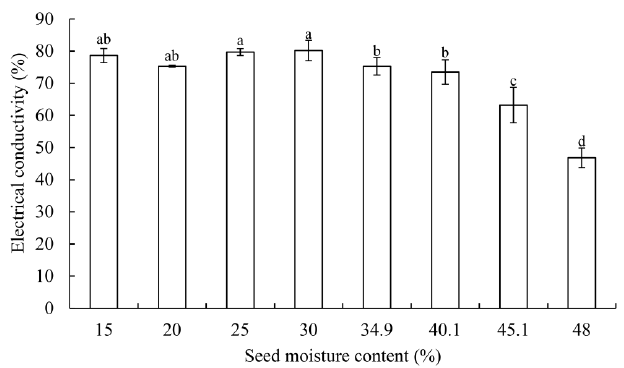
Figure 4. Changes of electrical conductivity in G. biloba seeds during desiccation. Data are means of three replicates ± SD, and bars labeled with the same lower-case letter do not differ significantly at the 0.05 probability level.